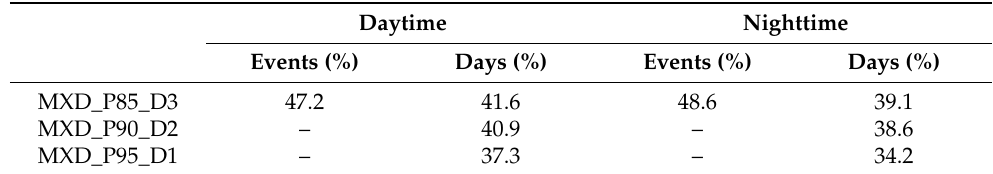
Table 2. Overall match percentage corresponding to the percent of heatwave events and days that coincide with LST anomalies.